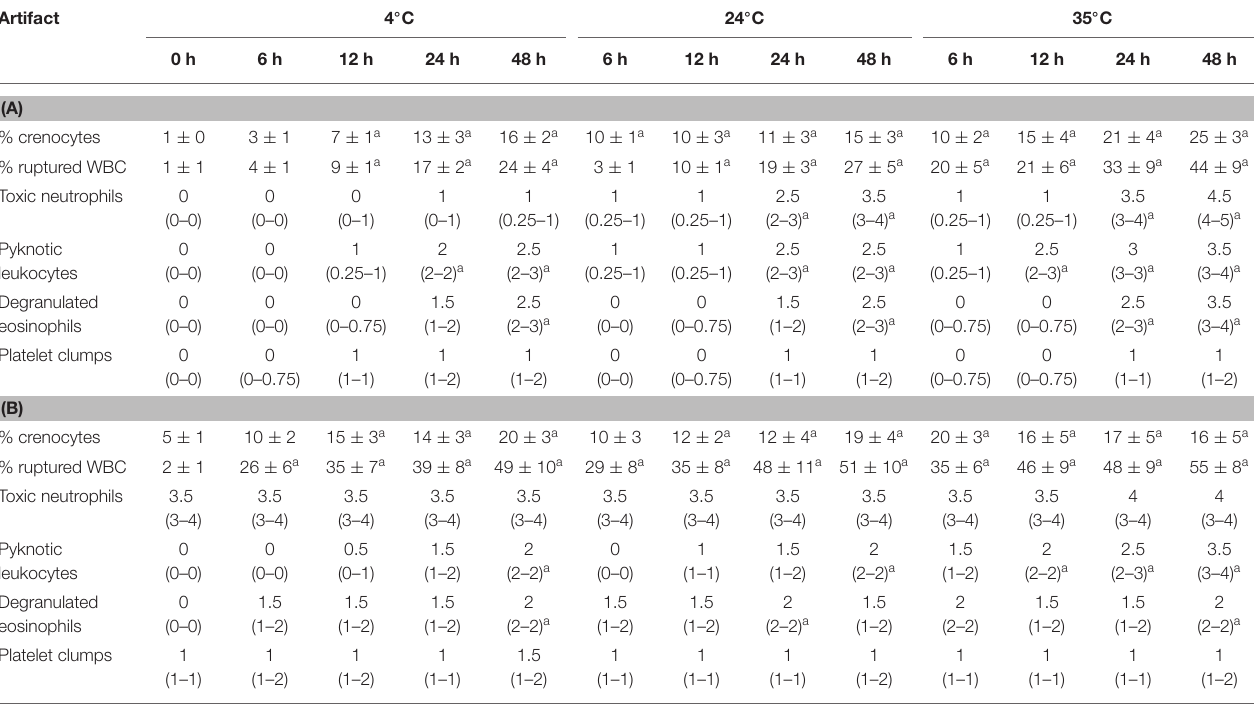
TABLE 2 | Effect of temperature and time storage on morphological findings in blood smears from healthy donkeys (A) and donkeys with experimentally-induced endotoxemia (B) .